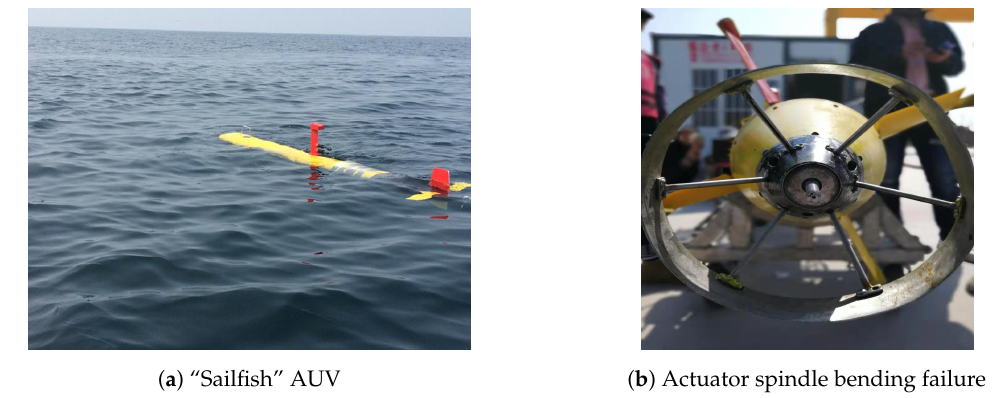
Figure 10. “Sailfish” autonomous underwater vehicle (AUV) and actuator spindle bending